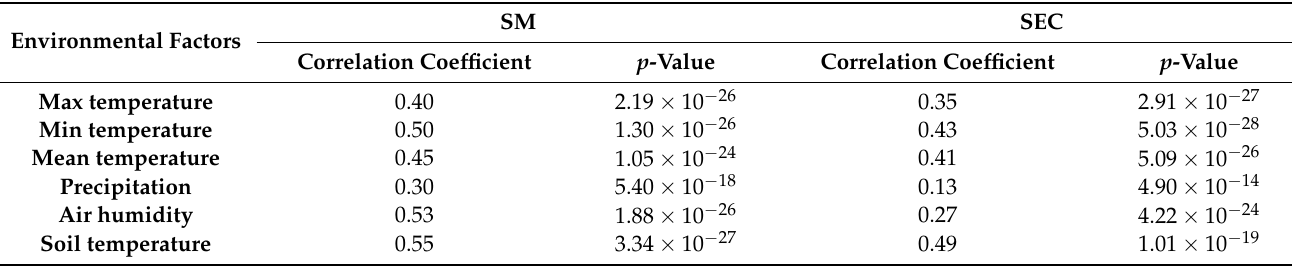
Table 1. Correlation coefficient and p -value results between the environmental information and SM and SEC. Environmental